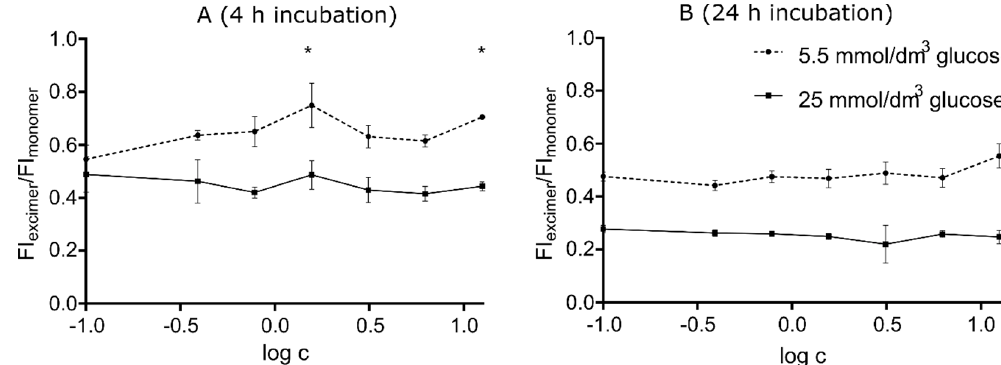
Figure 4. Alterations in the fluidity of the membrane in cells exposed to different silver nanoparticle concentrations were estimated by the ratio of fluorescence intensity of pyrene excimer and monomer. Cells (1 × 10 4 per well) were cultured in 5.5 mmol/dm 3 and 25 mmol/dm 3 glucose concentration medium and incubated with silver nanoparticles for 4 ( A ) and 24 ( B ) h. AgNPs were used in concentrations: 0.39, 0.78, 1.56, 3.125, 6.25, and 12.5 µg/cm 3 , concentrations were logarithmized for graphing purposes. Comparison of cells grown in medium with different glucose levels was performed by comparing areas under the curves with Student’s t-test, n = 3, α = 0.05. Differences between varying concentrations of silver nanoparticles in the same medium were tested with anova followed by Dunnett’s post hoc test and marked with *.